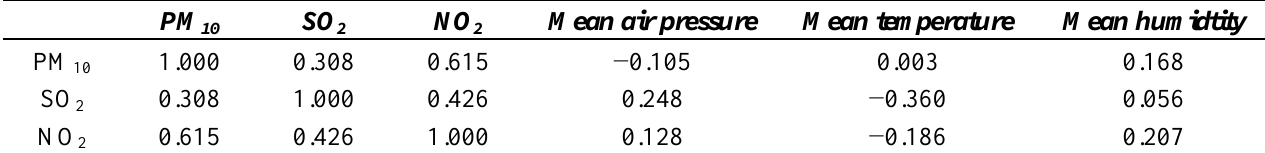
Table 3. Pearson coefficients of daily deaths, air pollutants and meteorological